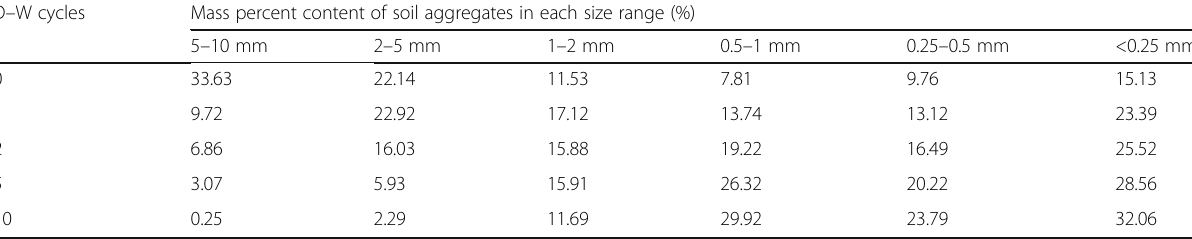
Table 2 The distribution of grain size of soil aggregates under drying – wetting cycles D – W cycles